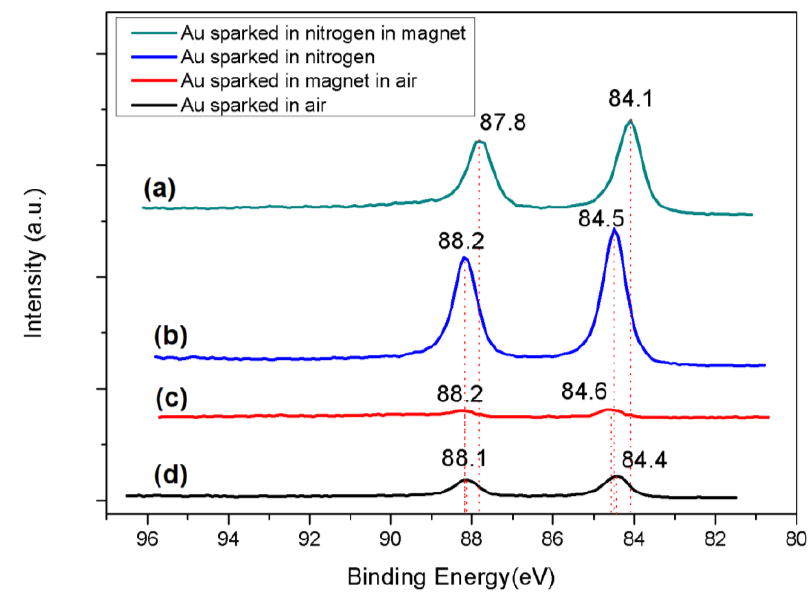
Figure 4. Au 4f XPS. Spectra collected under four conditions. ( a ) Gray—Au sparked in nitrogen flow under magnetic field, ( b ) blue—Au sparked in nitrogen flow without magnet, ( c ) red—Au sparked in ambient air under magnetic field, ( d ) black—Au sparked in air.